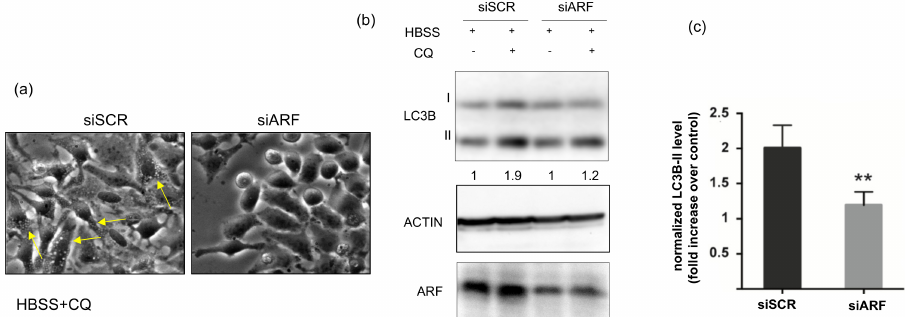
Figure 1. Effect of ARF silencing on autophagy upon starvation. HeLa cells treated with the indicated siRNAs were incubated in Hanks buffered salt solution (HBSS) to induce amino acid and growth factors starvation and with 50 µ M chloroquine (CQ) to inhibit lysosome-mediated degradation. Living cells were analysed by phase-contrast microscopy ( a ) and Western blot ( b ) to measure LC3 lipidation (LC3I to LC3II conversion). Actin is a loading control. ARF Western shows the silencing efficiency. LC3B-II levels normalized vs. actin are shown as fold increase relative to CQ − cells (arbitrarily set to 1) below the Western. Graph on the right-hand side ( c ) represents the quantification of normalized LC3 levels from three independent replicates performed with ImageJ. Error bars indicate SD, n = 3. ** p <